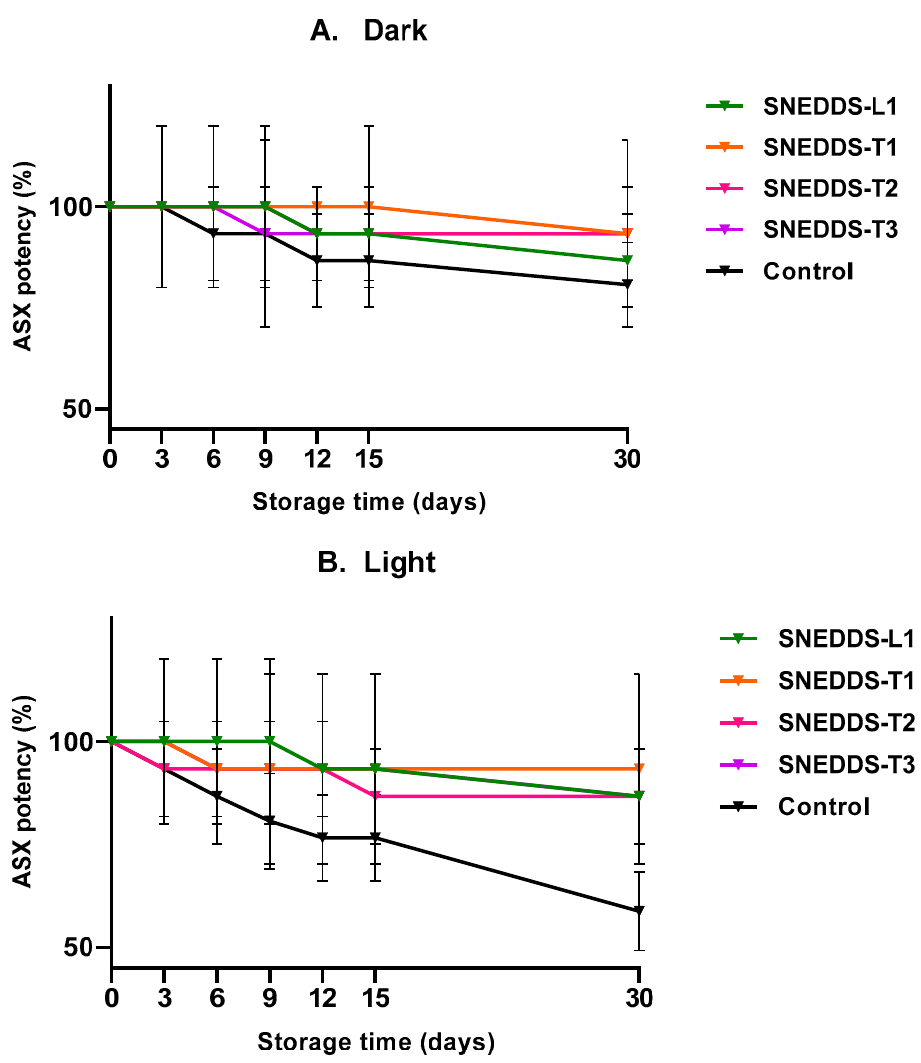
Figure 4. % ASX remaining after 30 day storage of SNEDDS formulations and ASX in oil (control) at room temperature in the dark ( A ) and light ( B ) conditions (mean ± SD; n = 3).